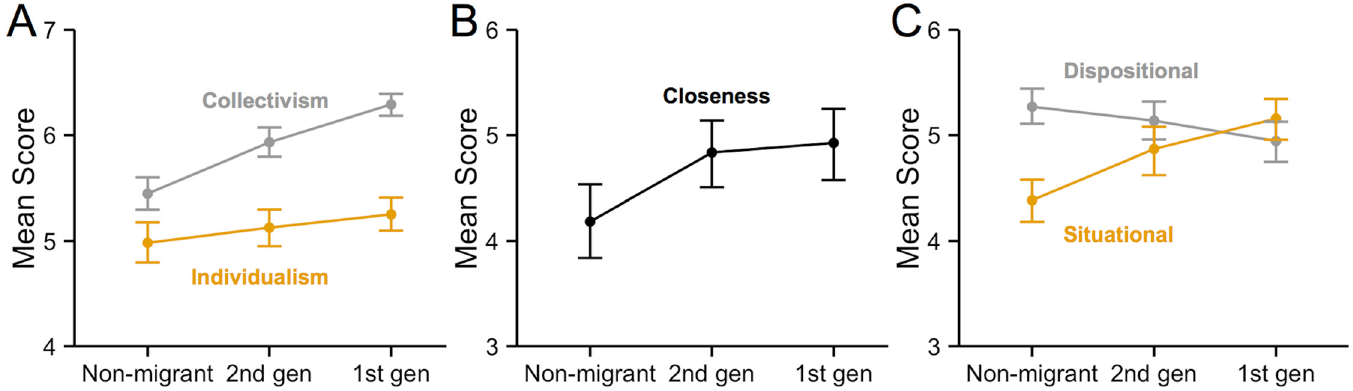
Fig 1. Cultural group differences indicated as meaningful by the culture-only regression analyses, for (A) social orientation, (B) closeness to a significant other, and (C) dispositional/situational attribution. Error bars show 95% confidence intervals. 1 st gen = 1 st generation British Bangladeshi, 2 nd gen = 2 nd generation British